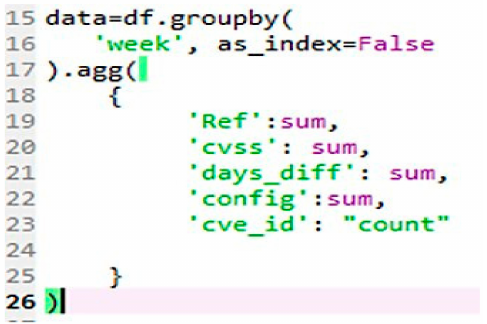
Figure 2. Creation of